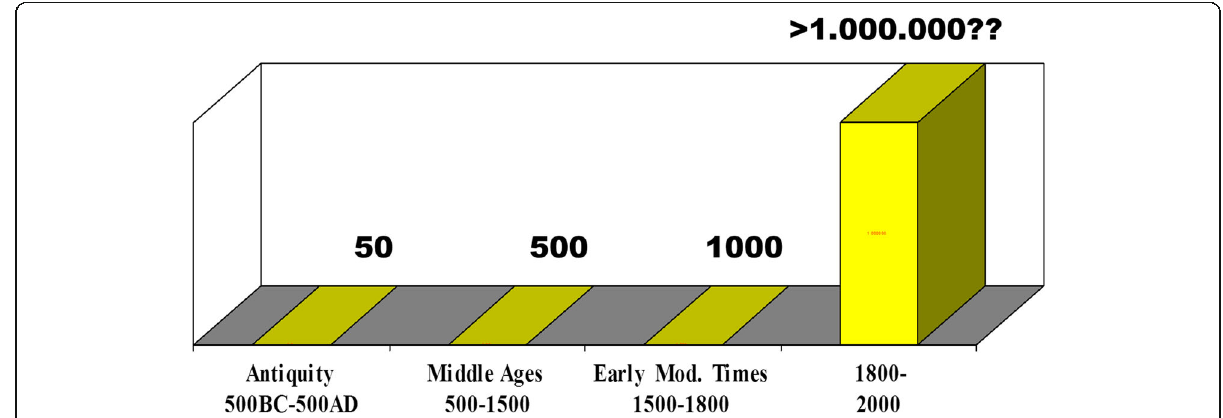
Fig. 2 Estimated numbers of medical sources in the history of stroke across centuries. Drawing by the